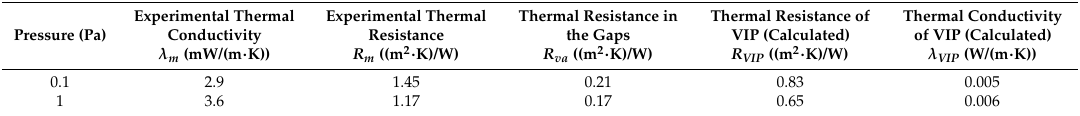
Table 1. Experimental results by GHP.